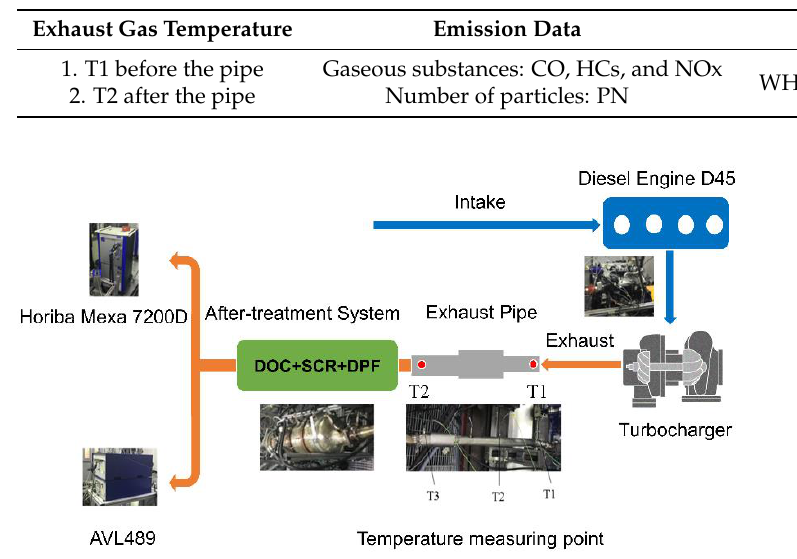
Figure 2. Layout of the test bench and temperature measurement points.